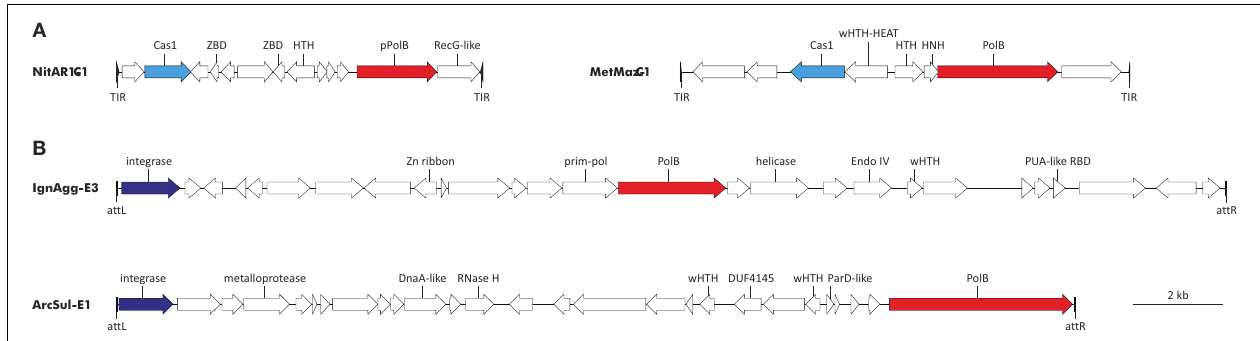
FIGURE 3 | Genome maps of archaeal PolB-encoding mobile genetic elements. (A) Casposons of families 1 and 2. NitAR1-C1 is present in the genome of Candidatus Nitrosopumilus koreensis AR1 (NC_018655; nucleotide coordinates: 655308 to 663492), whereas MetMaz-C1 is from Methanosarcina mazei Go1 (NC_003901; nucleotide coordinates: 3946601 to 3956653). (B) Tyrosine recombinases-encoding elements. IgnAgg-E3 is found in the genome of Ignisphaera aggregans DSM 17230 (NC_014471; nucleotide coordinates: 1844012 to 1868704) and ArcSul-E1 is from